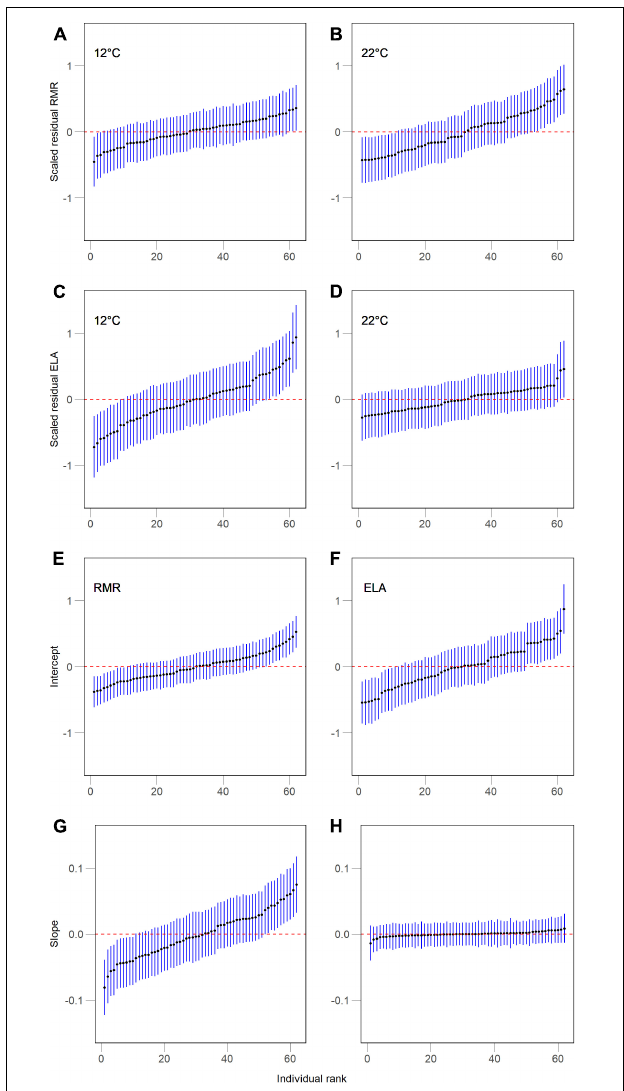
FIGURE 2 | Individual random intercepts of resting metabolic rate (RMR) and exploratory locomotor activity (ELA) at two body temperatures (A–D) and as parameters of their thermal reaction norms, intercepts and slopes (E–H) in juvenile Alpine newts ( Ichthyosaura alpestris ). Values are estimates (SE) of best linear unbiased predictors (BLUP) for each individual from their respective model ( Tables 1 , 3 ).